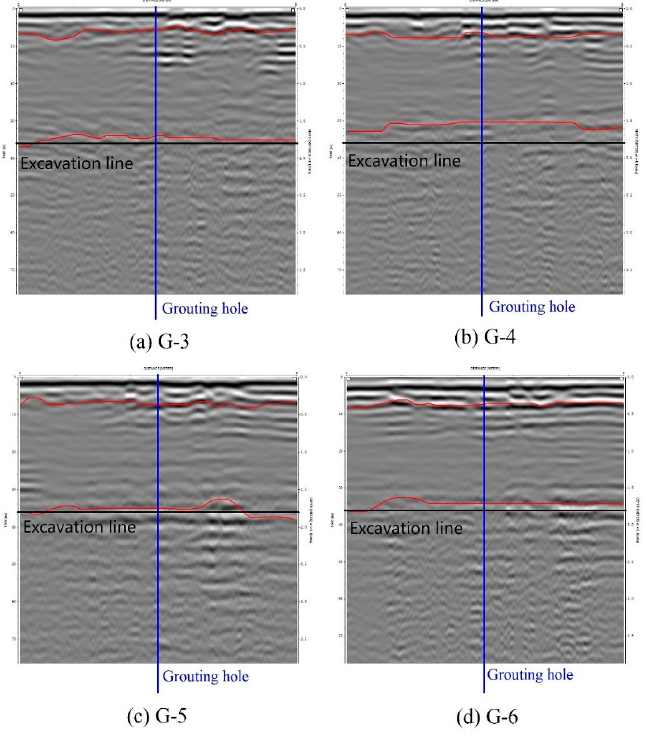
Figure 13. Photographs of GPR in the vertical direction.